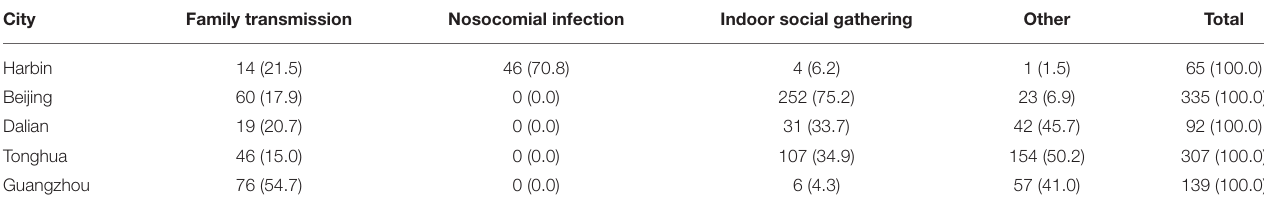
TABLE 2 | Infection routes of outbreaks in five cities. City Family